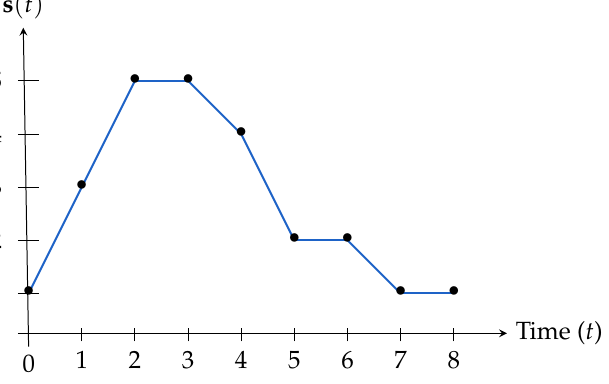
Figure 3. Example of scores describing the intensity of wine flavor showing a unimodal